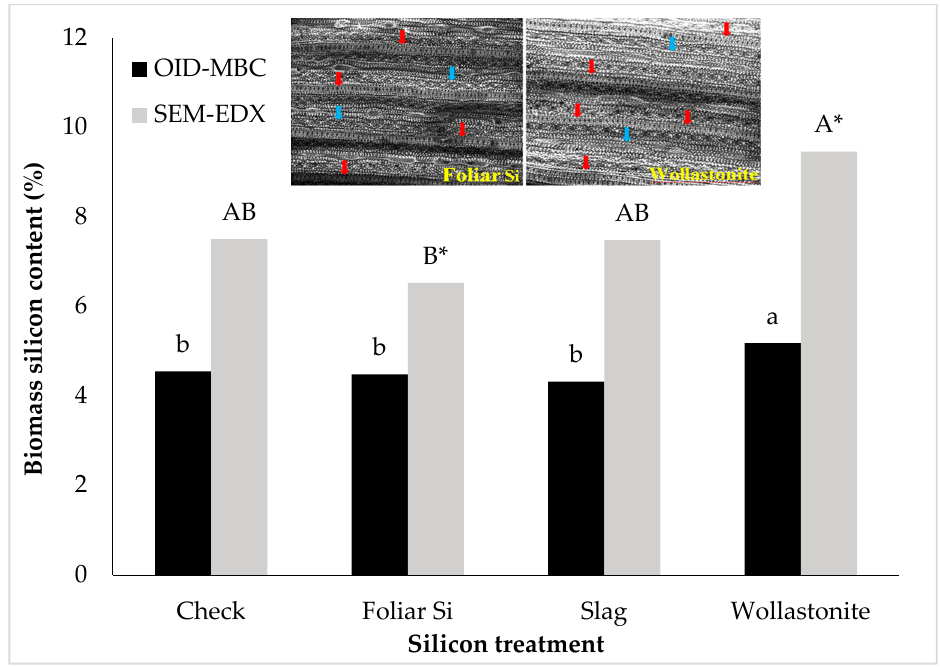
Figure 7. Effect of silicon treatments on leaf silicon content based on Oven Induced Digestion–Molybdenum Blue Colorimetric (OID-MBC) and Scanning Electron Microscopy–Energy Dispersive X-ray (SEM-EDX). Bars labeled with the same upper or lower case letters are not significantly different at P < 0.05 according to Tukey’s test. Inset (*): Scanning electron microscopy images (400 times magnification) of rice leaves showing silica bodies on leaf surface of rice treated with foliarly applied Si (1) and wollastonite (2). Red arrows = dumbbell shape silica bodies; blue arrows = globular shape silica bodies.